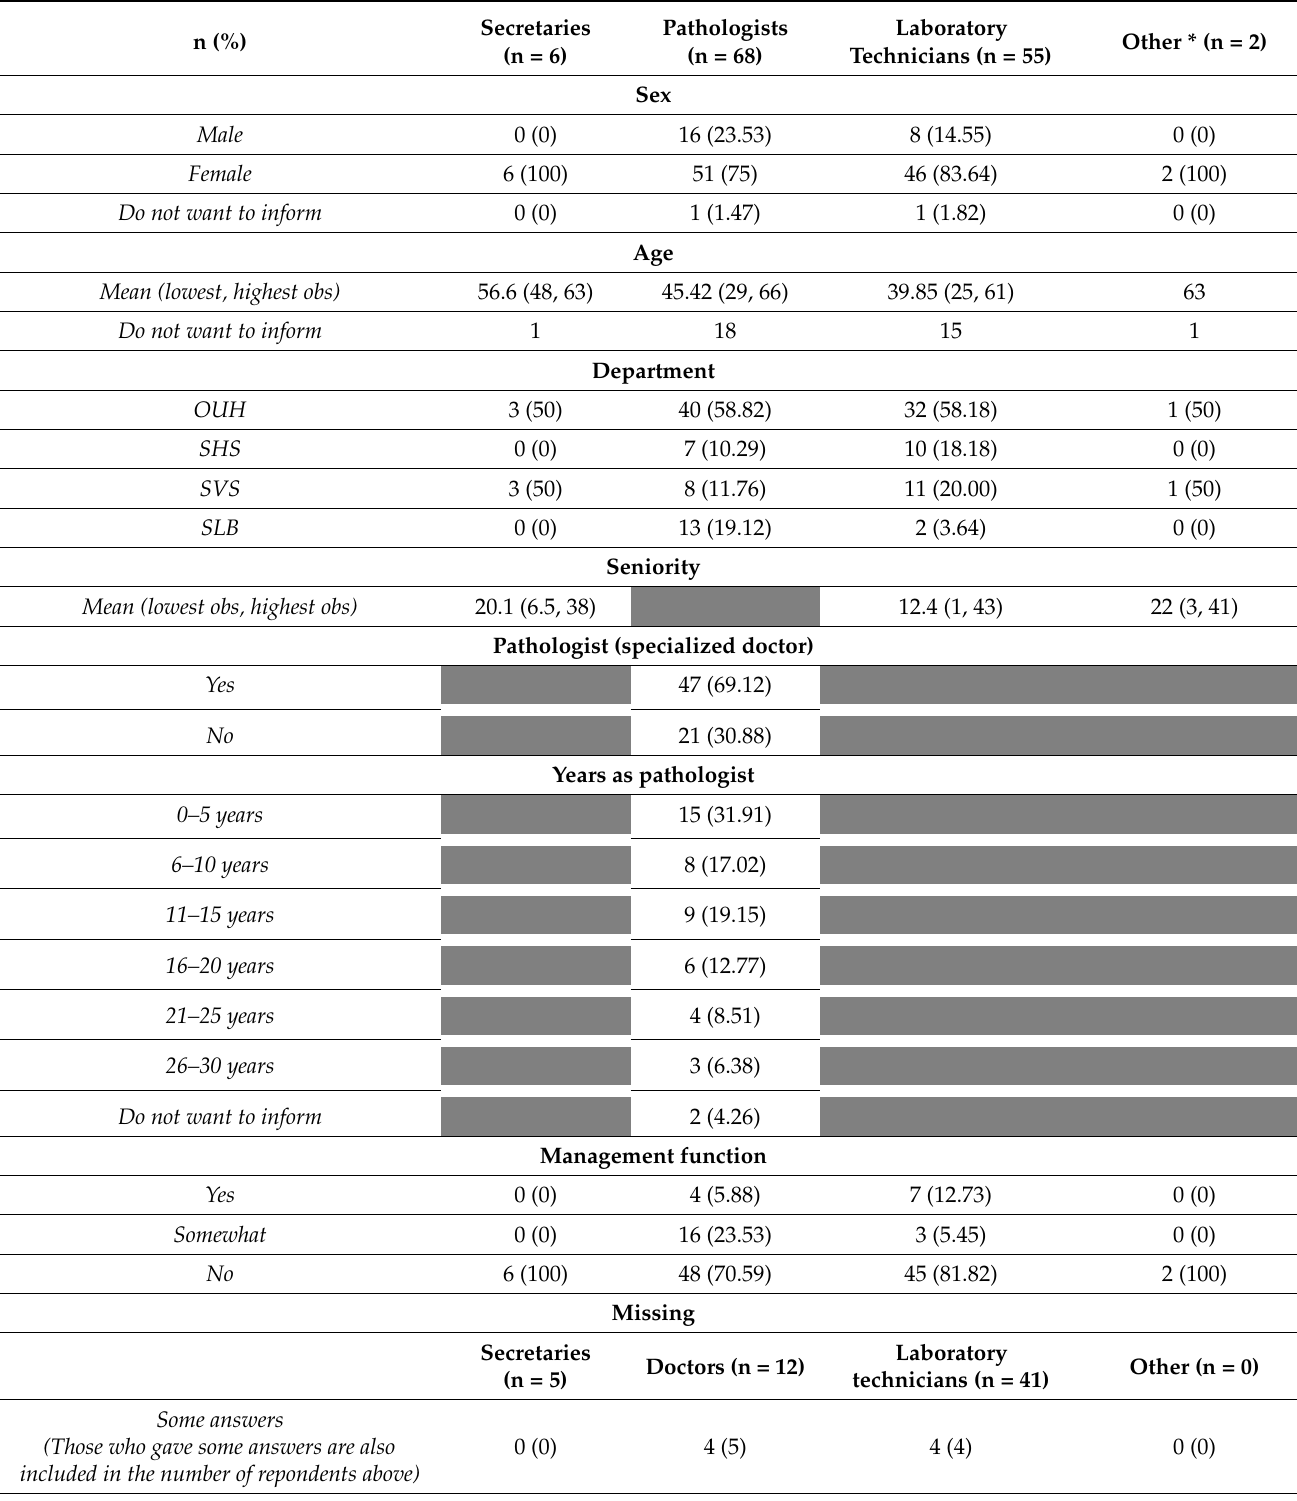
Table 3. Characteristics of